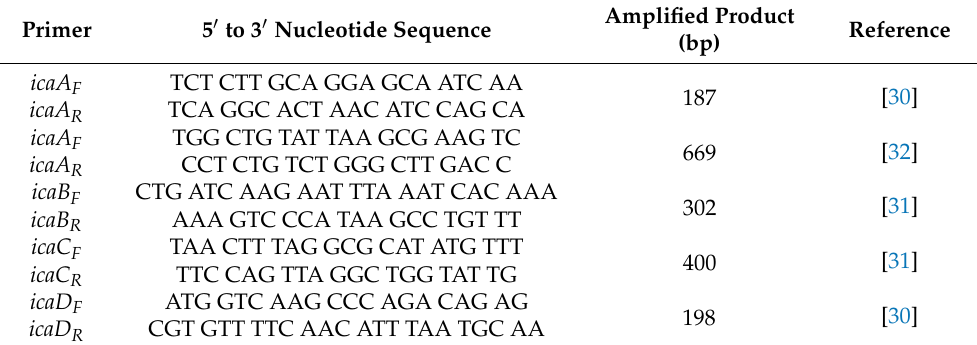
Table 4. Oligonucleotides used for the detection of the icaA , icaB , icaC , and icaD genes. Primer 5 (cid:48) to 3 (cid:48) Nucleotide